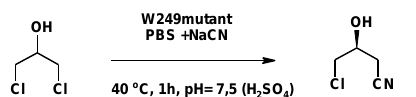
Figure 7. Continuous synthesis of ( S )-4-chloro-3-hydroxybutanenitrile ( S -CHBN) from 1,3-DCH and NaCN catalyzed by halohydrin dehalogenase (HheC).